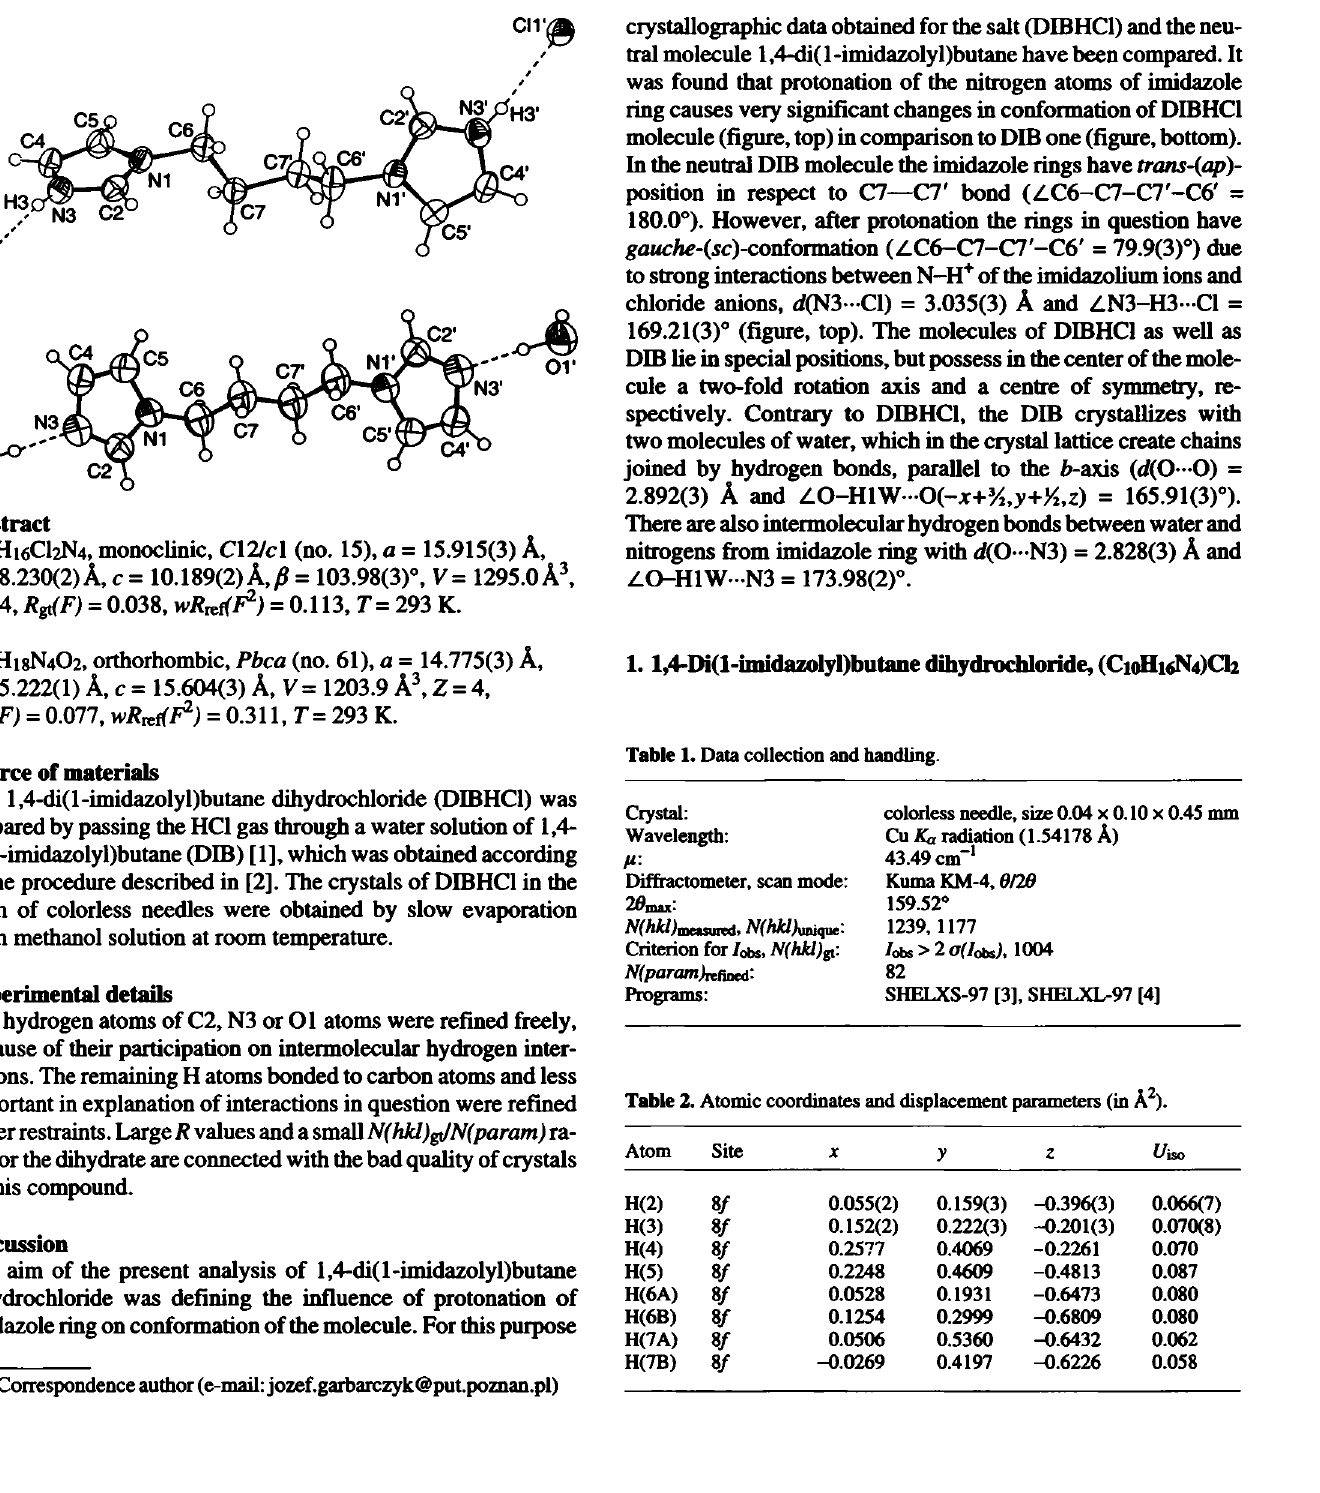
Table 2. Atomic coordinates and displacement parameters (in Ä 2